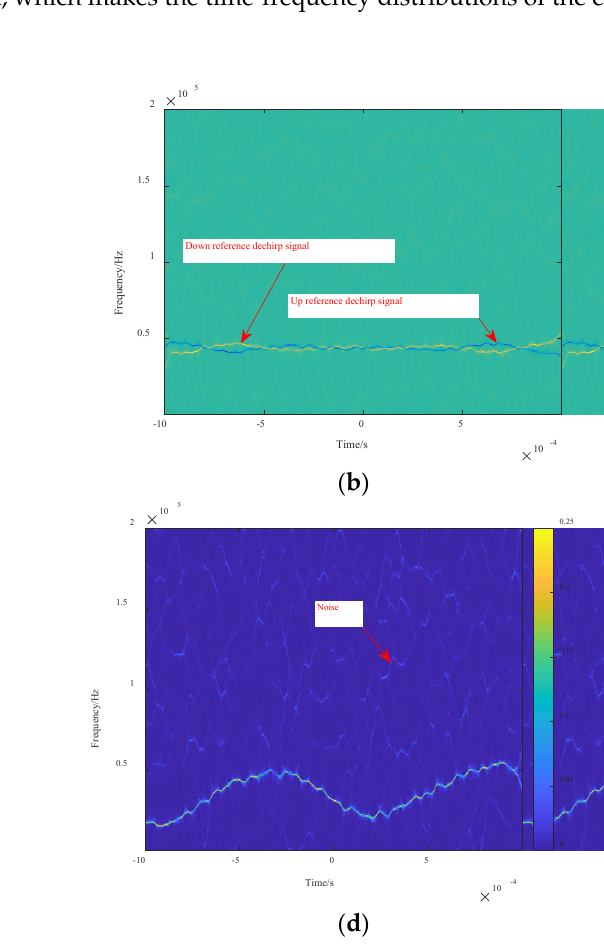
Figure 10. ( a ) Up and down reference dechirp signals with nonlinearity error and SNR of 10dB; ( b ) The second − order SST results of up and down reference dechirp signals; The second − order SST results of up measurement dechirp signal; ( c ) and down measurement dechirp signal ( d ).